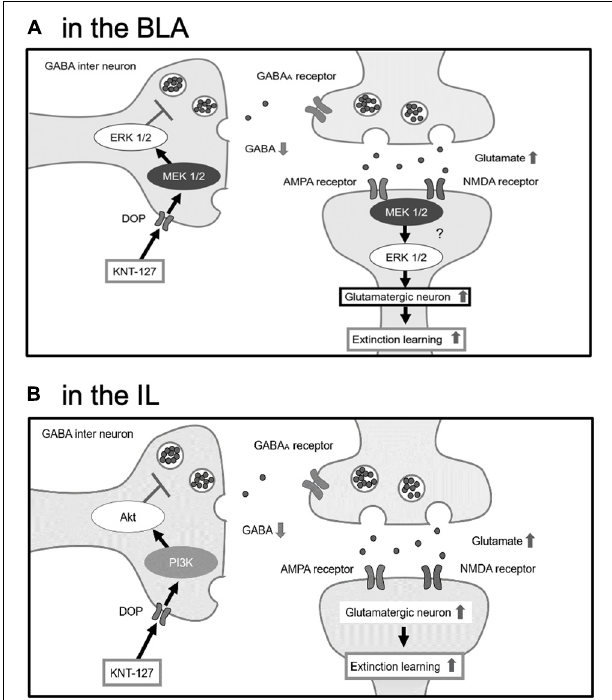
FIGURE 9 | The hypothesis that BLA and IL facilitate fear extinction through different signaling pathways. (A) In the BLA, KNT-127 exerts extinction-facilitating effect via ERK/MEK pathway. (B) In the IL, KNT-127 exerts extinction-facilitating effect via PI3K/Akt pathway. KNT-127 acting on DOPs on GABAergic interneuron in the BLA and IL produce the disinhibition of glutamatergic